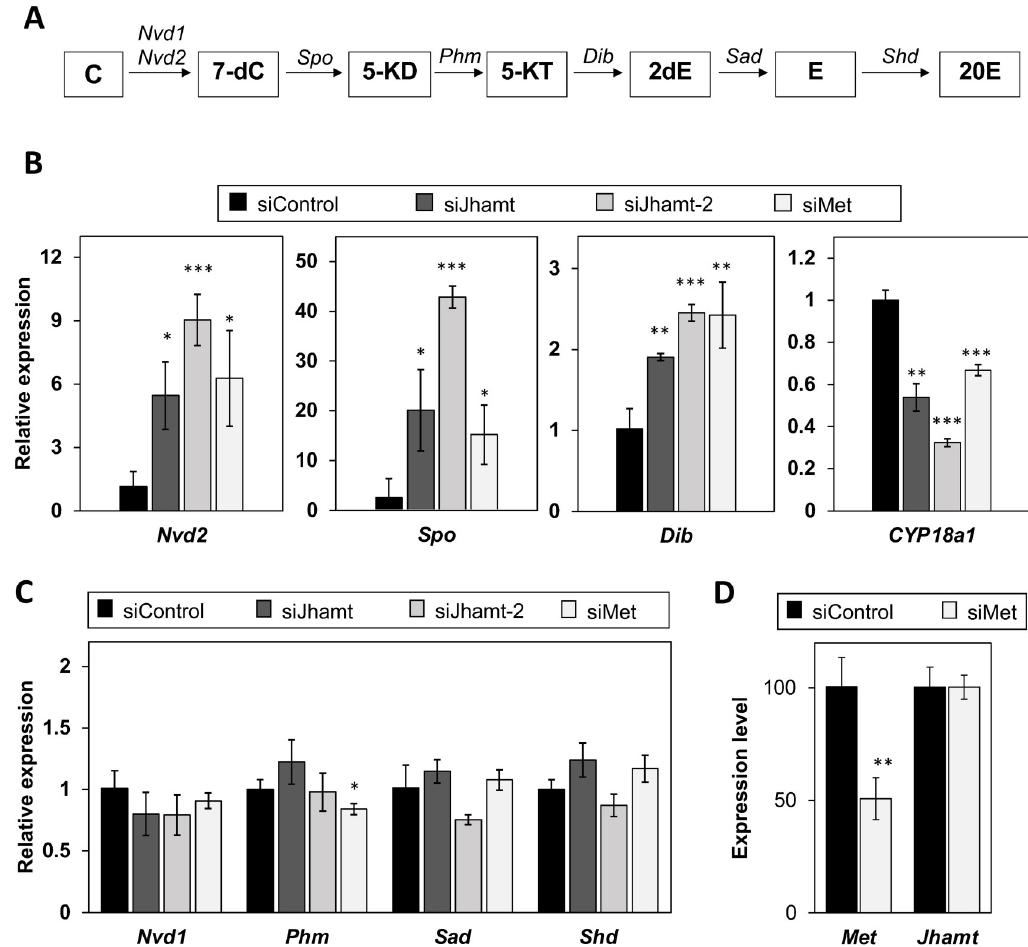
Fig 4. Jhamt knockdown upregulates expression of ecdysteroid biosynthesis genes at 24 hao. (A) Predicted ecdysteroid biosynthesis pathway in Daphnia magna . C: cholesterol; 7-dC: 7-dehydrocholesterol; 5-KD: 5 β -ketodiol; 5-KT: 5 β -ketotriol; 2dE: 2-deoxyecdysone; E: ecdysone; 20E: 20-hydroxyecdysone. Nvd: Neverland; Spo: Spook; Phm: Phantom; Dib: Disembodied; Sad: Shadow; Shd: Shade. (B) Expression of Nvd2 , Spo , Dib , and Cyp18a1 at 24 h in siControl, siJhamt and siMet embryos at 24 h after siRNAt as measured by qRT-PCR. (C) Expression levels of other ecdysteroidogenesis genes in siControl, siJhamt, and siMet embryos. Expression levels are normalized to those of ribosomal L32 , then shown relative to expression levels of siRNA- ctrl. Values are means. Error bars represent SD (N = 3). � p < 0.05; �� p < 0.01; ��� p < 0.001 (Student’s t